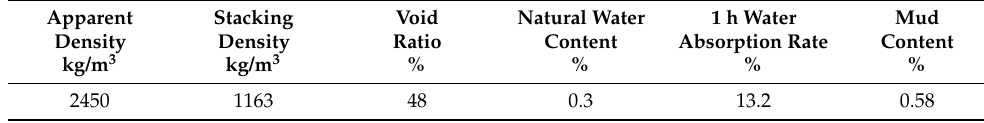
Table 3. Physical properties of coarse aggregate.